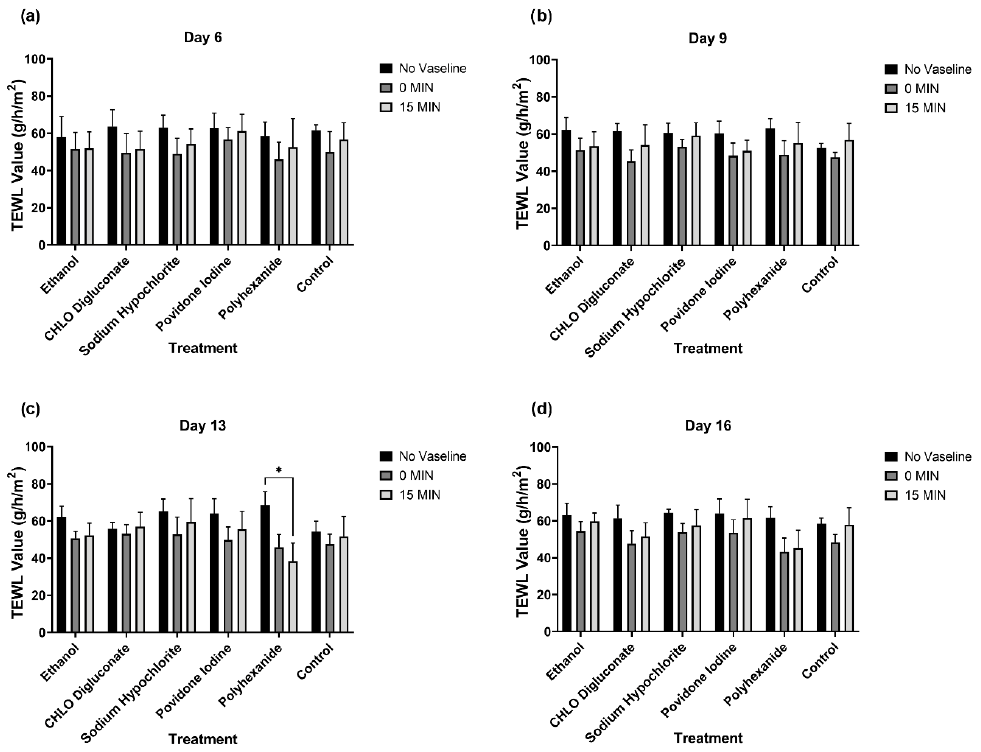
Figure 5. Statistical analysis of TEWL measurements of BASS treatment and control groups on day 6 ( a ), day 9 ( b ), day 13 ( c ), and day 16 ( d ). Graphic shows measures of BASS without Vaseline, with Vaseline at t = 0 min, and 15 min post-application. n = 3.